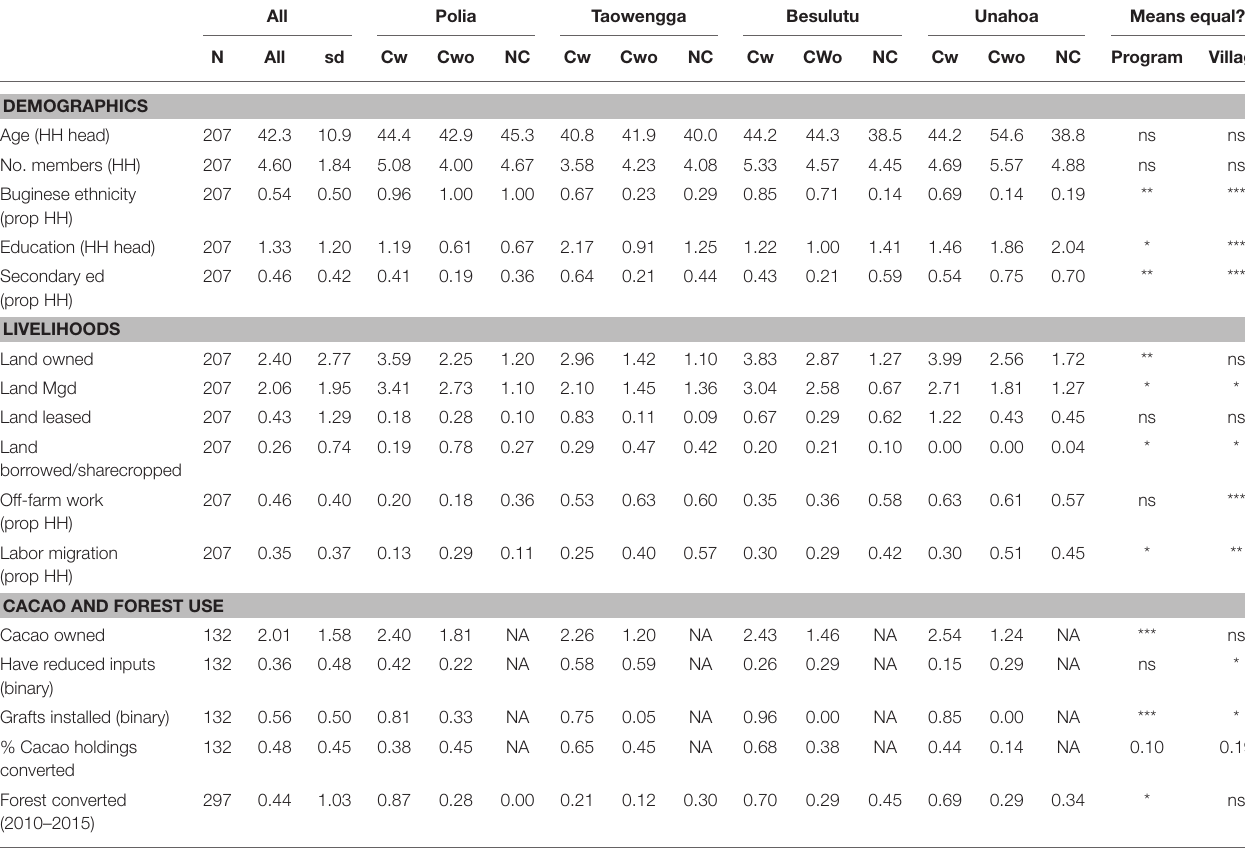
TABLE 4 | Educational, livelihood, and land disparities vis-à-vis cacao production and access to intensification initiatives. All Polia Taowengga Besulutu Unahoa Means equal?